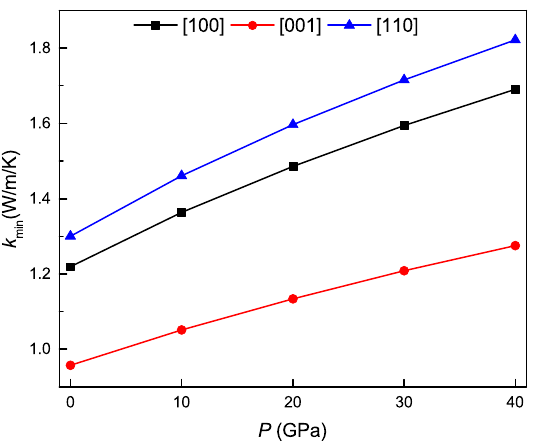
Figure 10. Minimum thermal conductivities in [100], [001] and [110] directions as a function of pressure for the Ti 4 Nb 3 Al 9 phase.